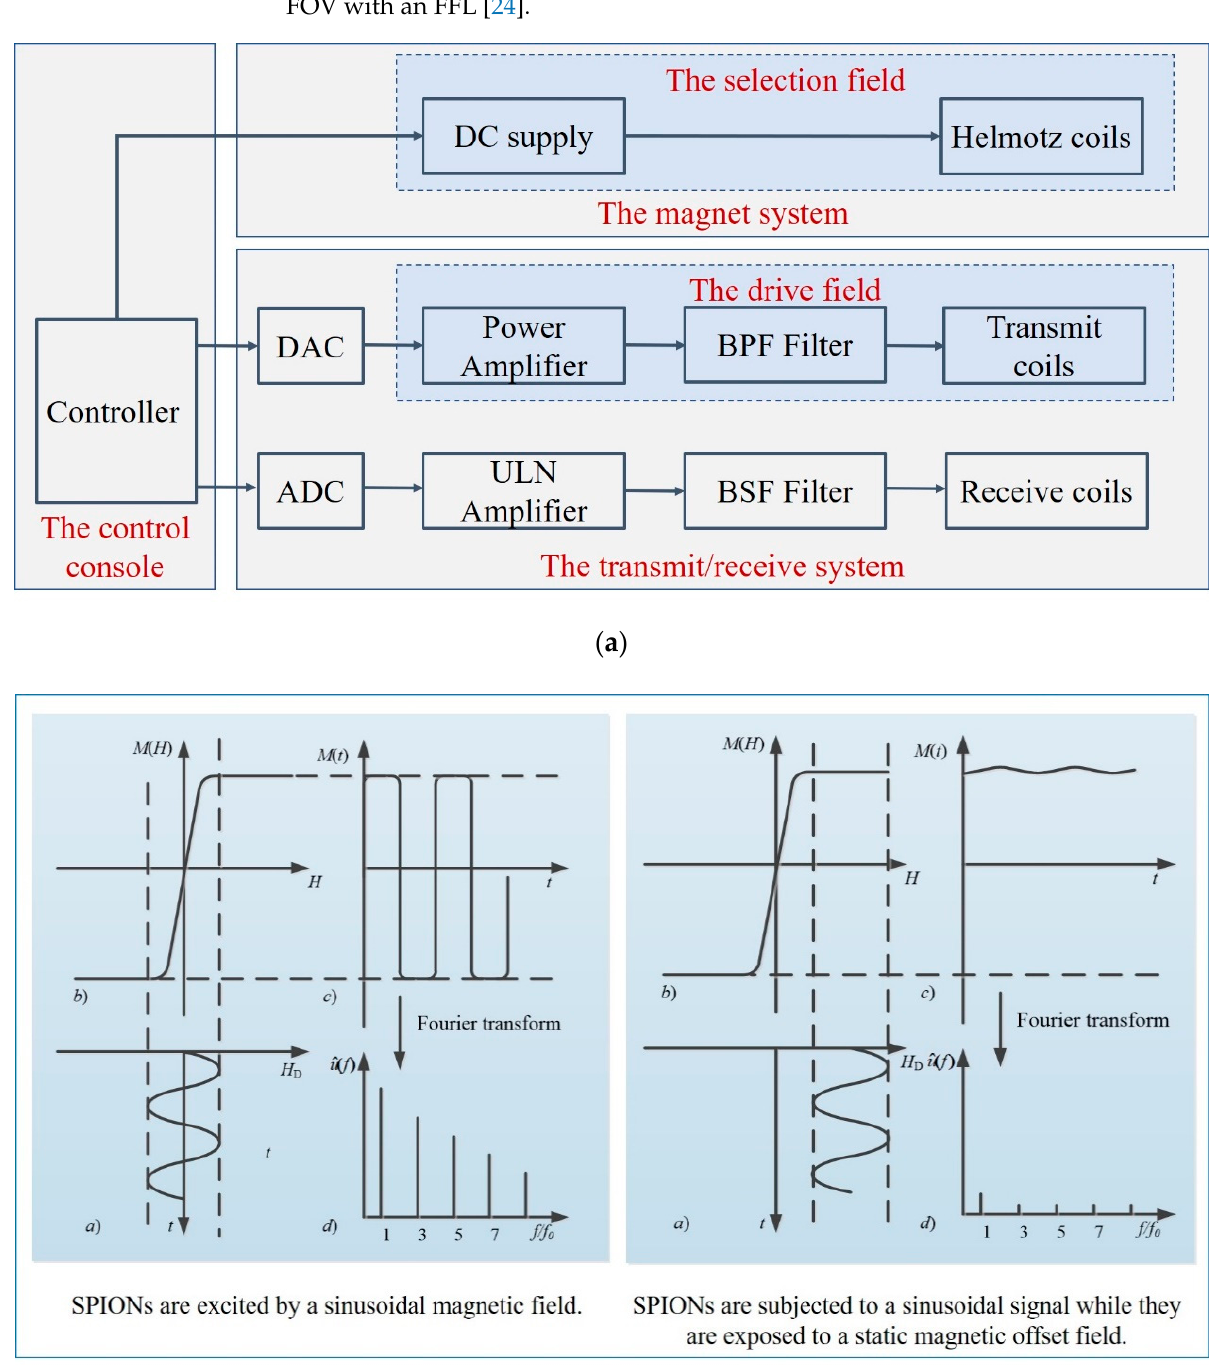
Figure 3. ( a ) Hardware structure of an MPI imaging system; ( b ) the basic principle of MPI.